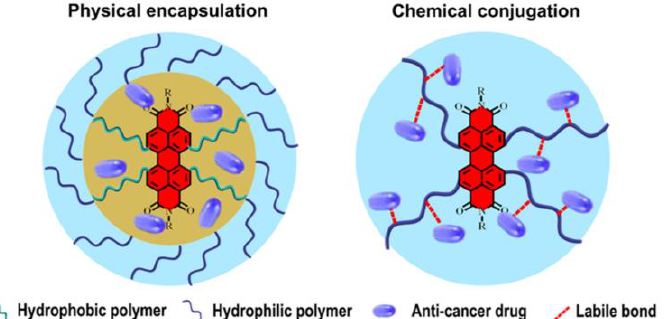
Figure 16. Physical and chemical loading of chemodrug with PDI-cored polymers. Reprinted with permission from reference [74]. Copyright 2019 American Chemical Society.